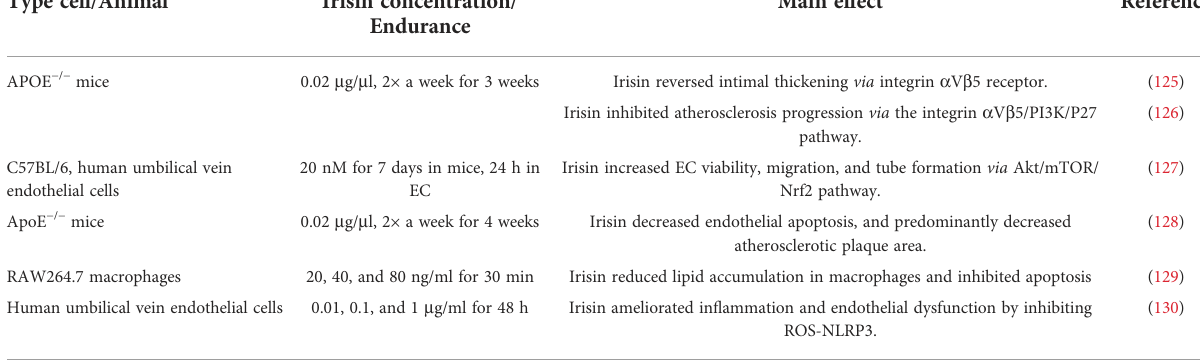
TABLE 2 The role of irisin in atherosclerosis. Type